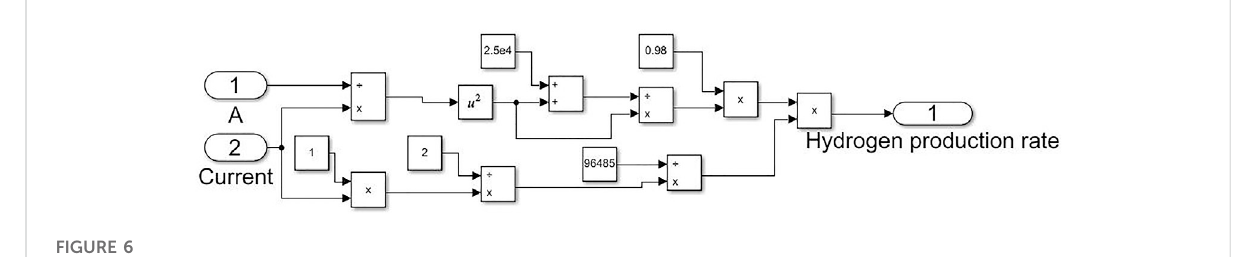
FIGURE 6 Hydrogen production rate model.